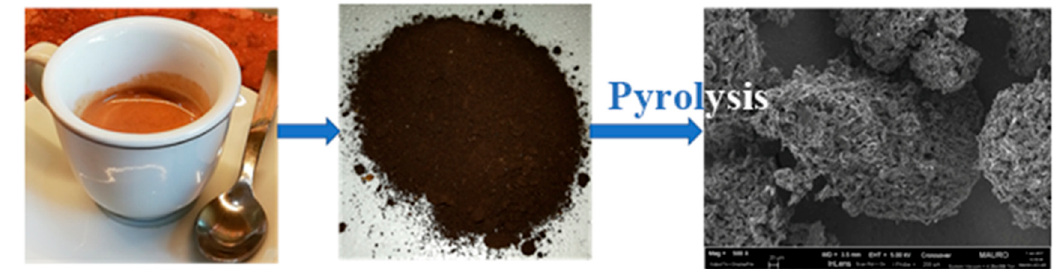
Figure 1. Conversion process of brewed coffee waste to carbon material.